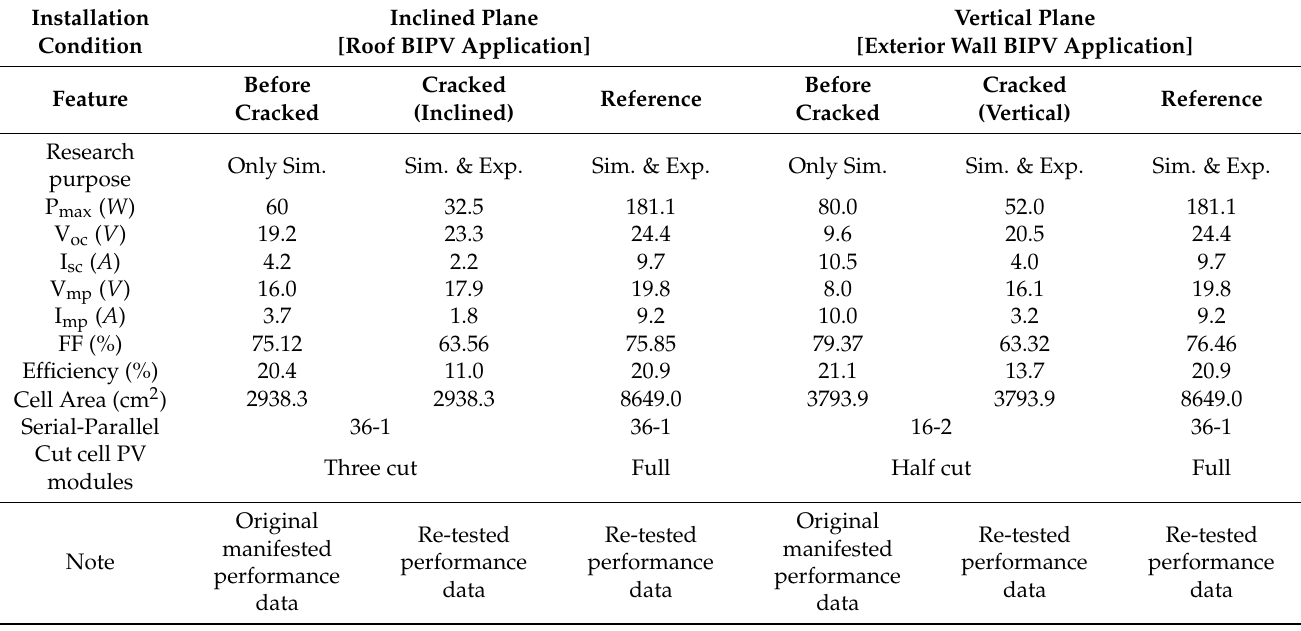
Table 1. Specification of each BIPV modules under Standard Test Condition (STC).